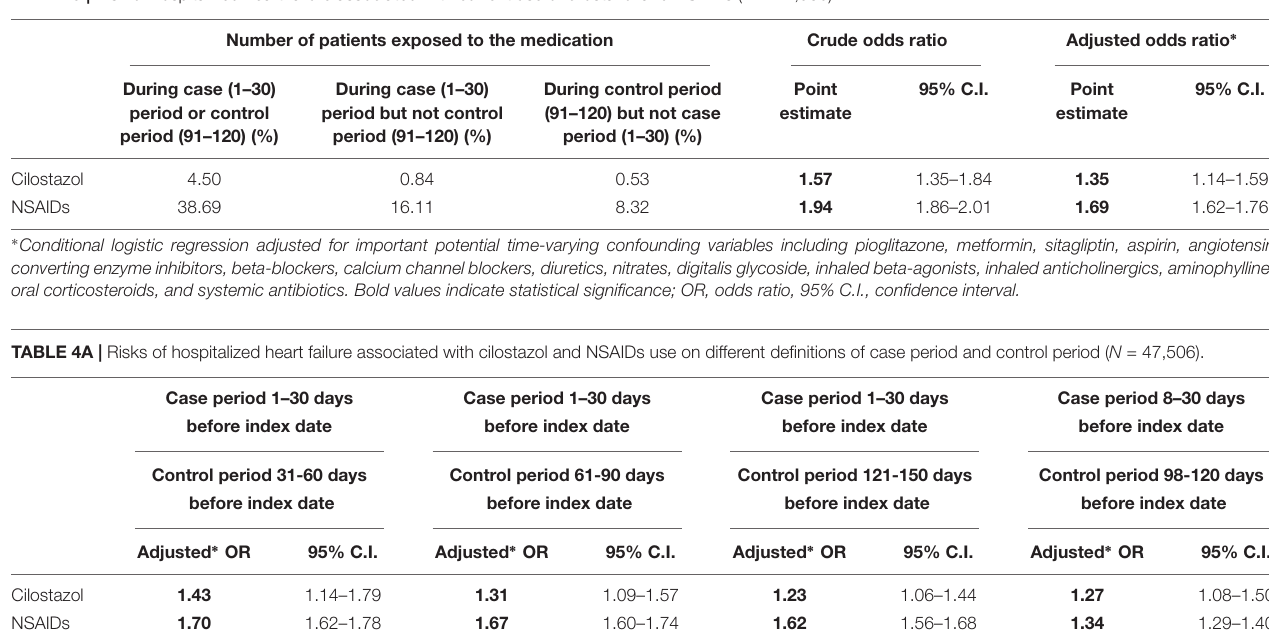
TABLE 3 | Risk of hospitalized heart failure associated with current use of cilostazol and NSAIDs ( N =